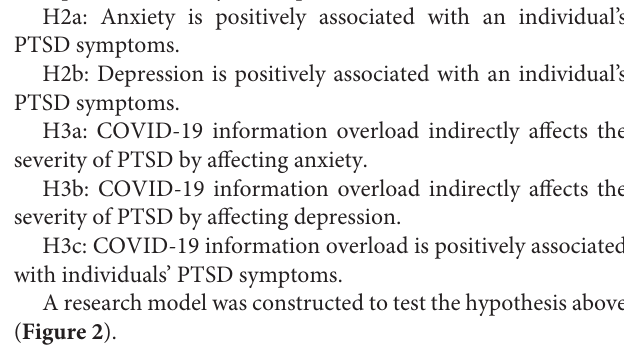
FIGURE 1 | Sampling flow chart.